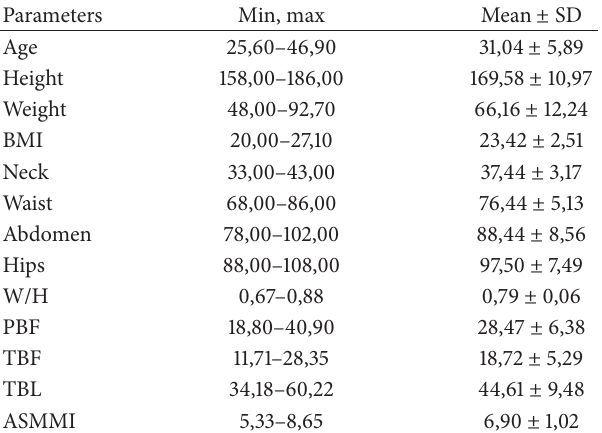
Table 1: Baseline characteristics of healthy volunteers.